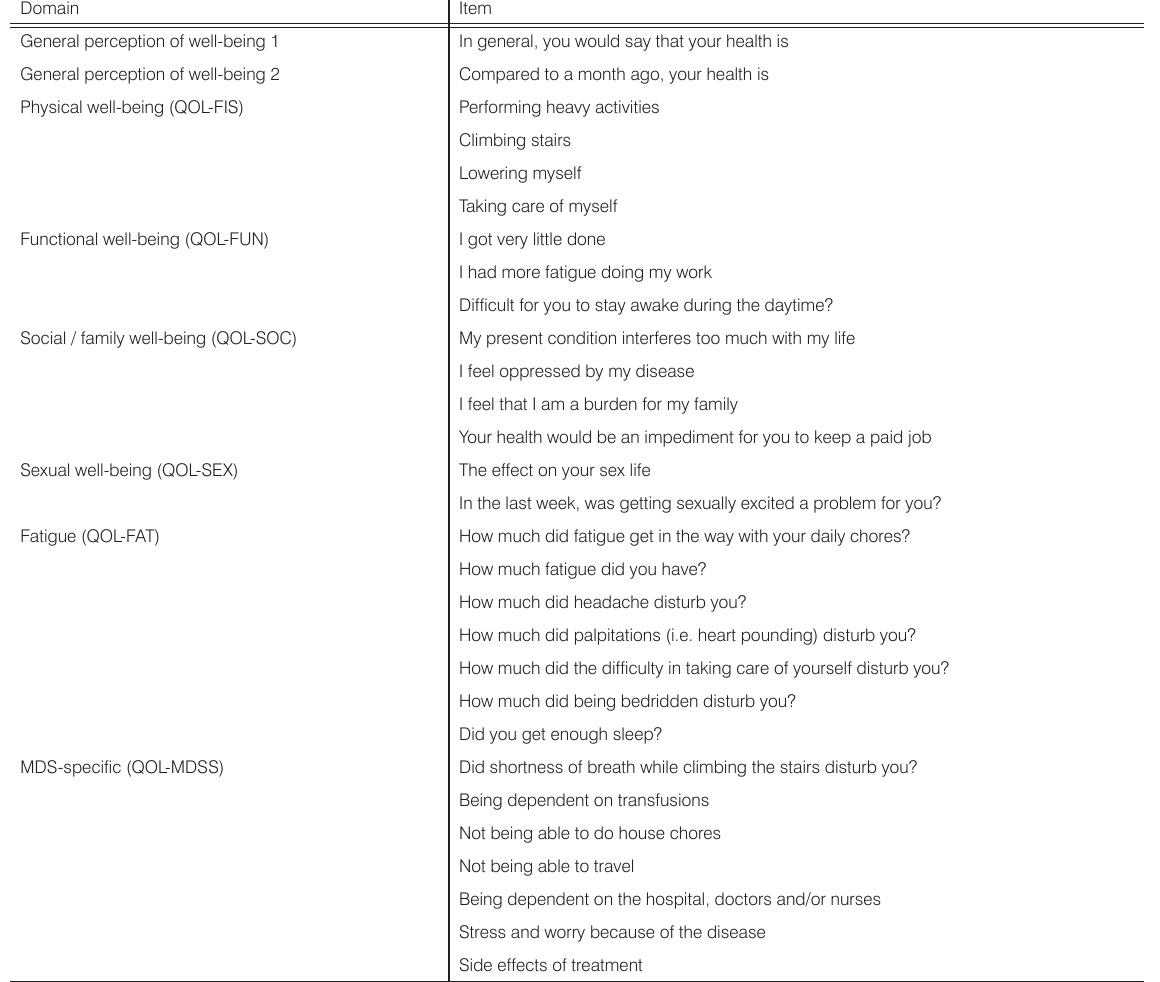
Table 3. QOL-E© V2.0 domains and items* Domain